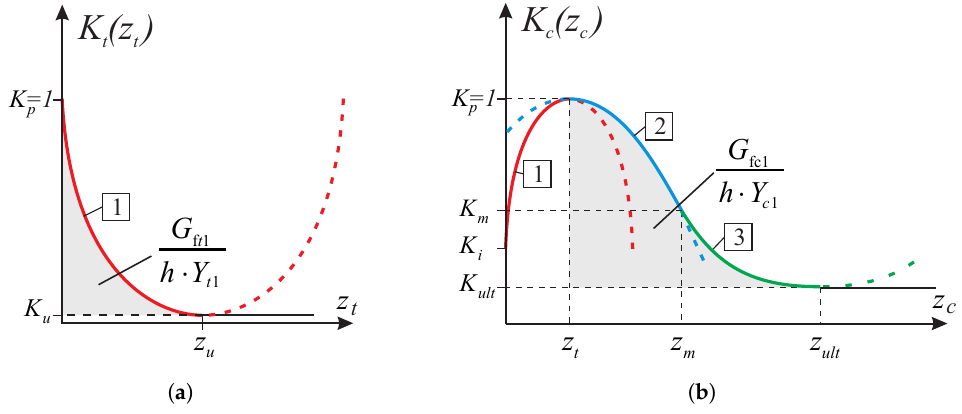
Figure 7. Degradation of material strength parameters curves adopted in the model: ( a ) tension regime, ( b ) compression